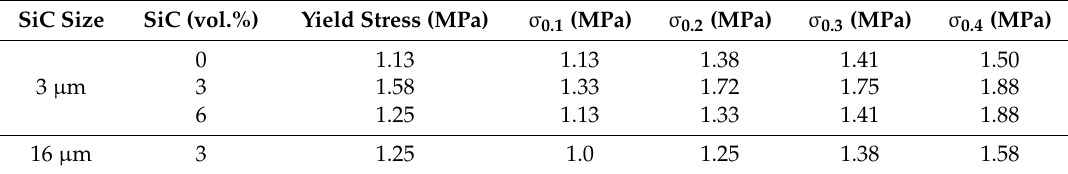
Table 3. Effect of the particle size and volume fraction of SiC particles on the compressive behavior of AlSi7 foams [34].